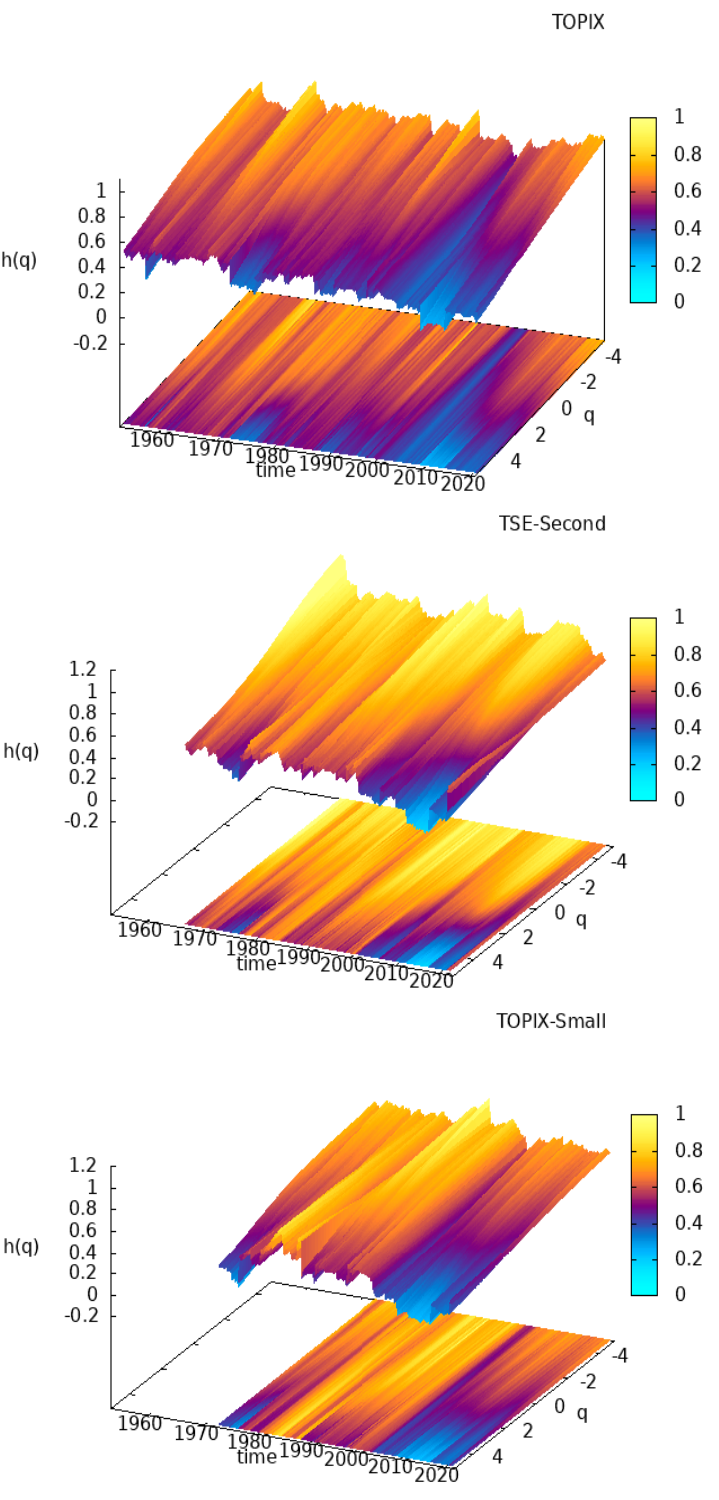
Figure 5. Three-dimensional plots of the GHE h ( q ) . The bottom plane in each plot represents a viewing map on the time- q